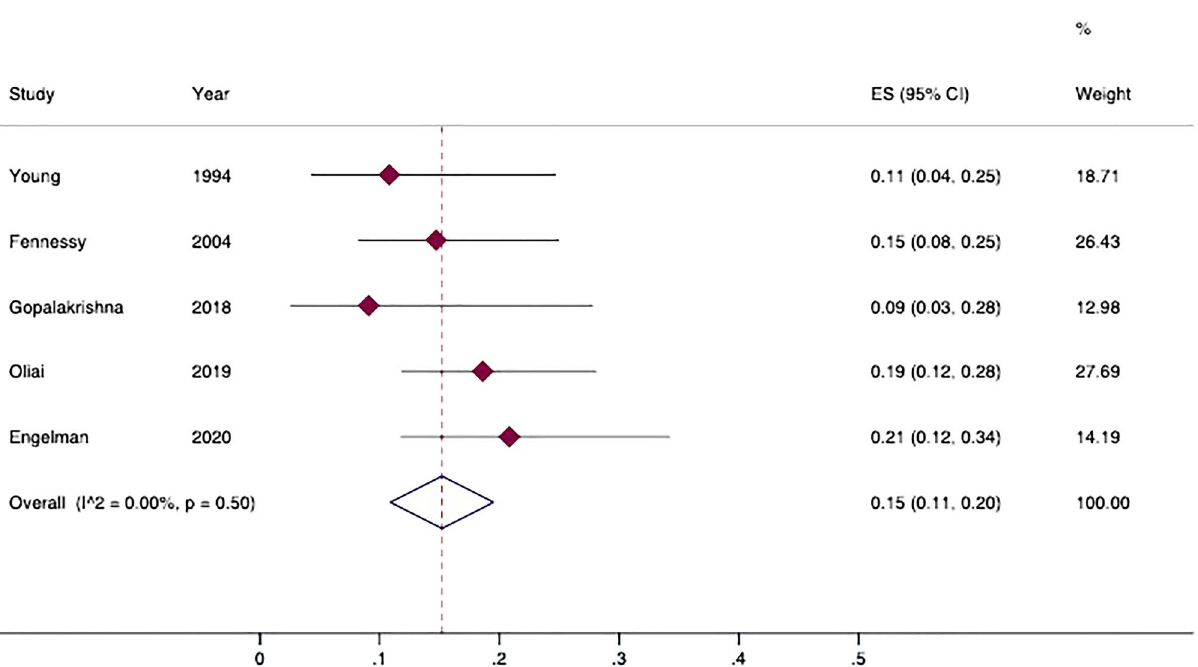
Figure 4. Prevalence of varices in patients with pseudocirrhosis. Forest plot of overall pooled prevalence of varices (random effect model); data from observational studies. 95%CI: 95% Confidence Intervals; ES: effect size; I 2 :